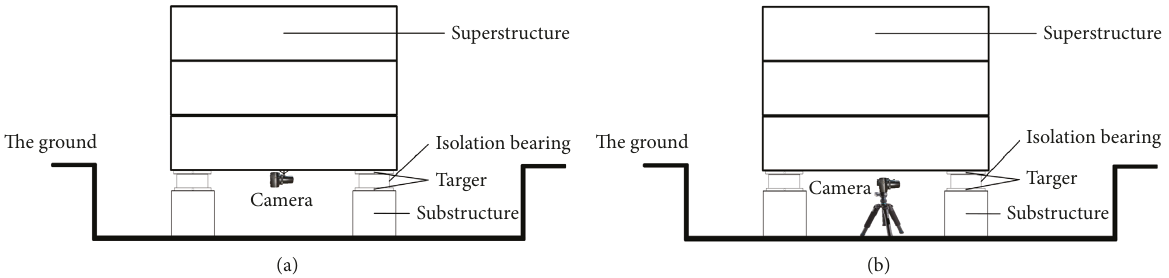
Figure 1: Schematic diagram of camera arrangement for dynamic displacement measurement of isolation bearings. (a) The first ar- rangement of the camera. (b) The second arrangement of the camera.